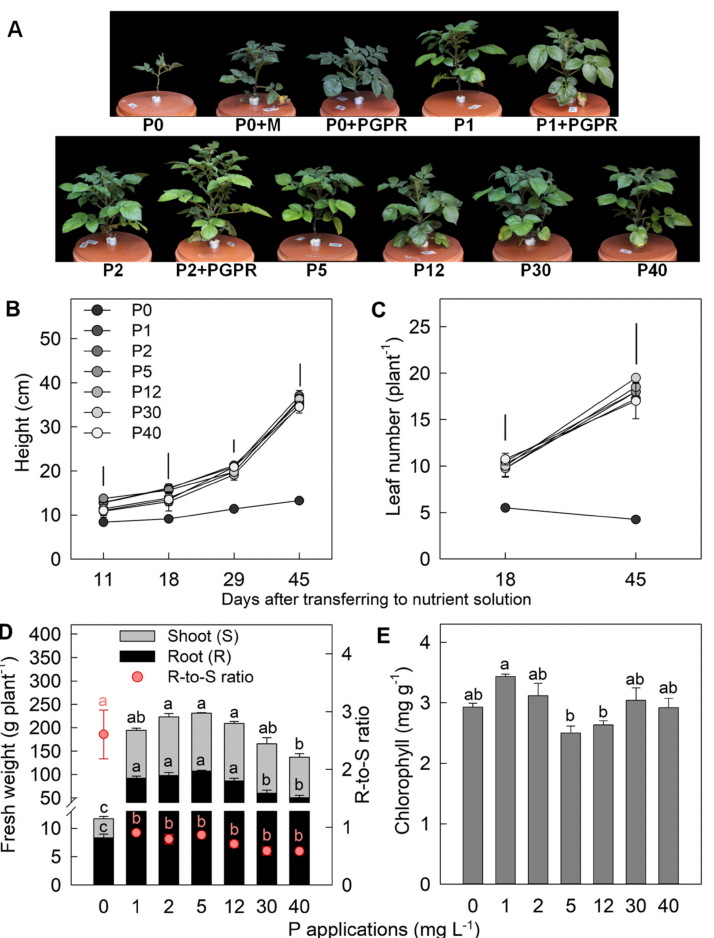
Figure 1. ( A ) Plant shoot phenotype at 30 days after seedling transplanting (DAT) as affected by differ- ent P levels and PGPR inoculation and ( B – E ) the influence of different P applications (0–40 mg L − 1